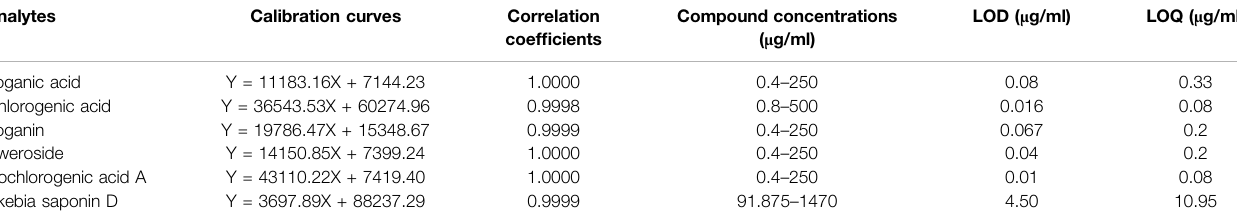
TABLE 1 | Method validation parameters of HPLC including linearity, limit of detection (LOD), and limit of quanti fi cation (LOQ) of six components.